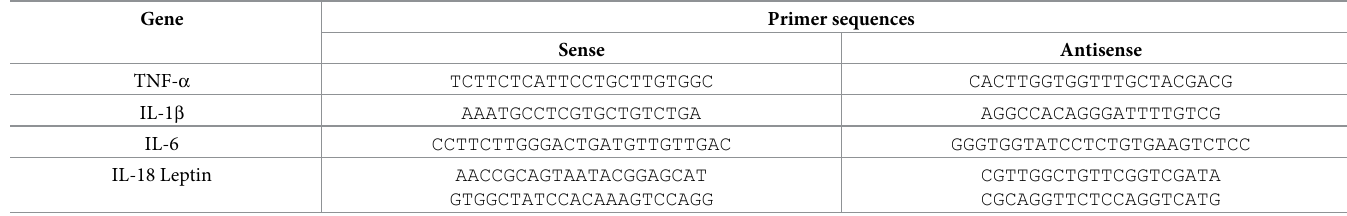
Table 1. Primer sequences (PCR-RT SYBR